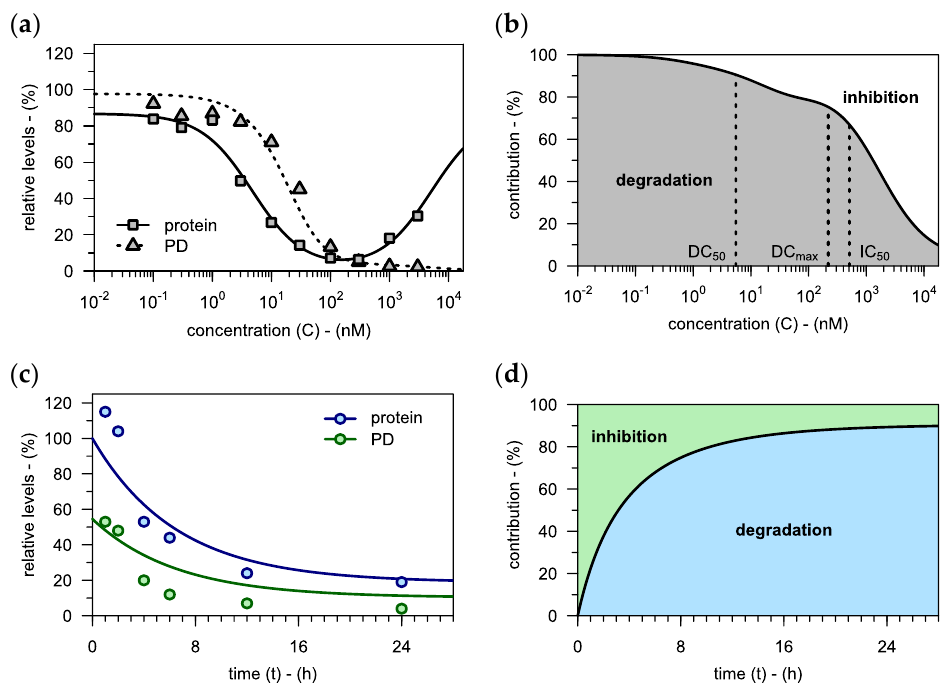
Figure 6. ( a ) Target protein levels and the downstream pharmacodynamic response are plotted against drug concentration for an in-house PROTAC (see Figure S3 for two more examples). The hook model is used to assess degradation, which is then used to fit the PD model (fitted to all three compounds simultaneously). As predicted by the model (see Appendix D for derivation), there is no hook effect present on the level of the downstream pharmacodynamic response. ( b ) The relative contributions of target degradation and target inhibition to the overall pharmacodynamic effect are plotted against PROTAC concentration. At higher drug concentrations, inhibition becomes the dominant driver of pharmacodynamic effects, thus compensating for the hook effect in protein levels. ( c ) Target protein levels and the downstream pharmacodynamic response are plotted against incubation time for an in-house PROTAC which was applied at a constant concentration of C = 100 nM. The time-course of degradation is predicted using the extended hook model (Equation (14)). Based on this prediction and considering the compound’s inhibitory potency, the PD model is used to also predict the time-course of the pharmacodynamic response. Both predictions are in good agreement with the observed data. ( d ) The relative contributions of target degradation and target inhibition to the overall pharmacodynamic effect are plotted against incubation time. Initially, the downstream pharmacodynamic effect is dominated by inhibition, but over time, degradation becomes more